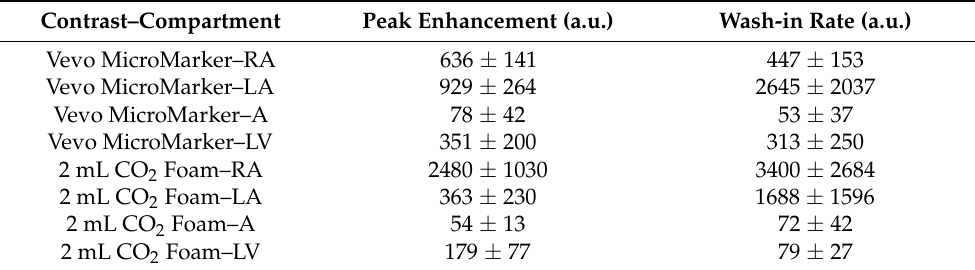
Table 1. Non-linear contrast imaging results after tail vein administration.